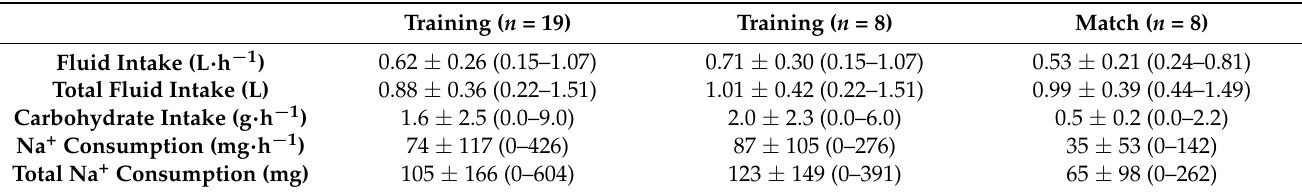
Table 3. Sweat test variables recorded before and during training and match (Mean ± SD (range)). Training ( n = 8) and match ( n = 8) only includes data of players that completed both the full training session and match. * indicates training significantly different to match ( p < 0.05)).